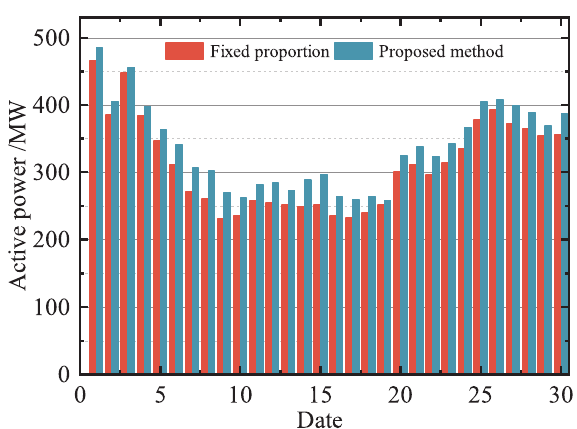
Figure 13. Comparison of wind power cluster output